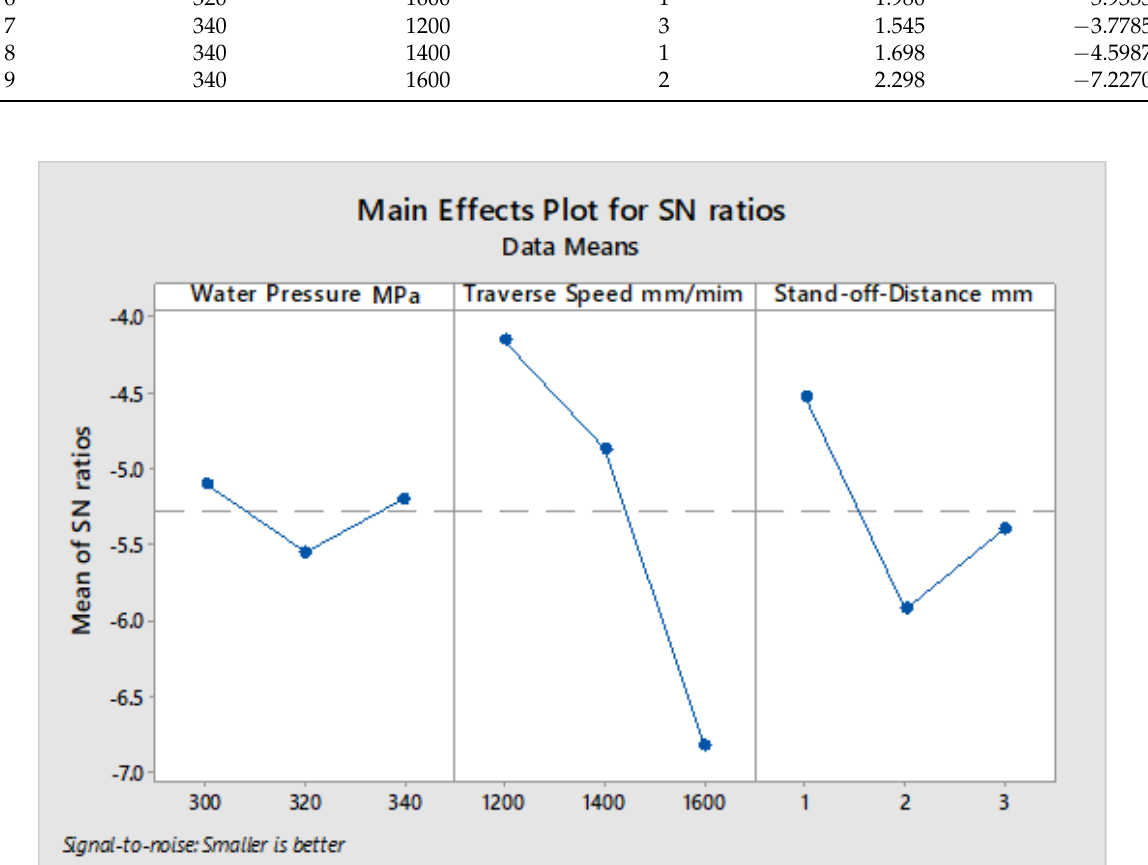
Figure 10. S/N ratio average value of input cutting parameters of the 6 mm thickness of sugar palm fiber reinforced unsaturated polyester (SPF-UPE) composite cut with abrasive water jet technique. Table 23. S/N ratio response table of input cutting parameters of the 6 mm thickness of SPF-UPE composite cut with abrasive water jet technique.